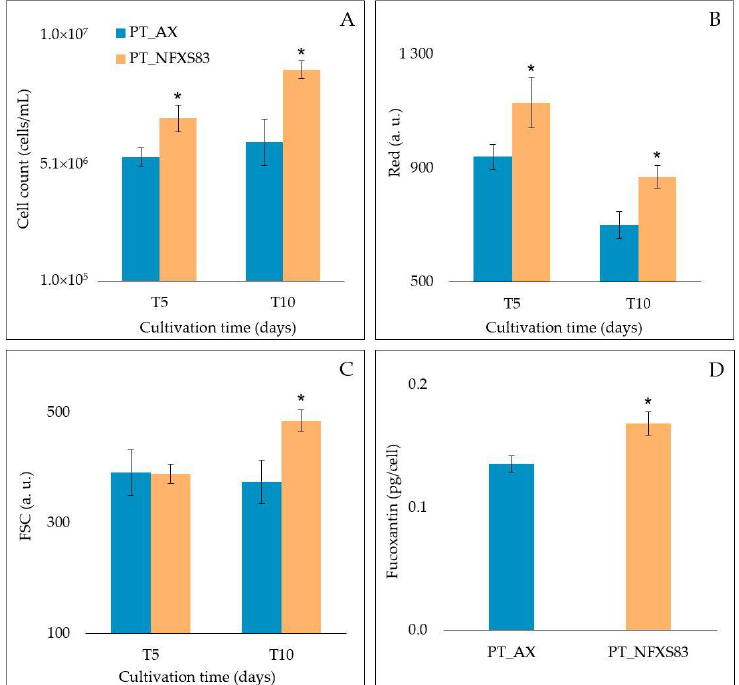
Figure 4. Growth dynamics of Phaeodactylum tricornutum cultivated under axenic conditions (PT_AX) and in co-cultivation with Saccharopolyspora sp. NFXS83 (PT_ NFXS83). ( A ) P. tricornutum cell count (cells/mL); ( B ) auto-fluorescence (Red); ( C ) front scatter (FSC); ( D ) fucoxanthin content (pg/cell) for T10. Values are average of n = 6 ± standard deviations. * Statistically significant ( p < 0.05).